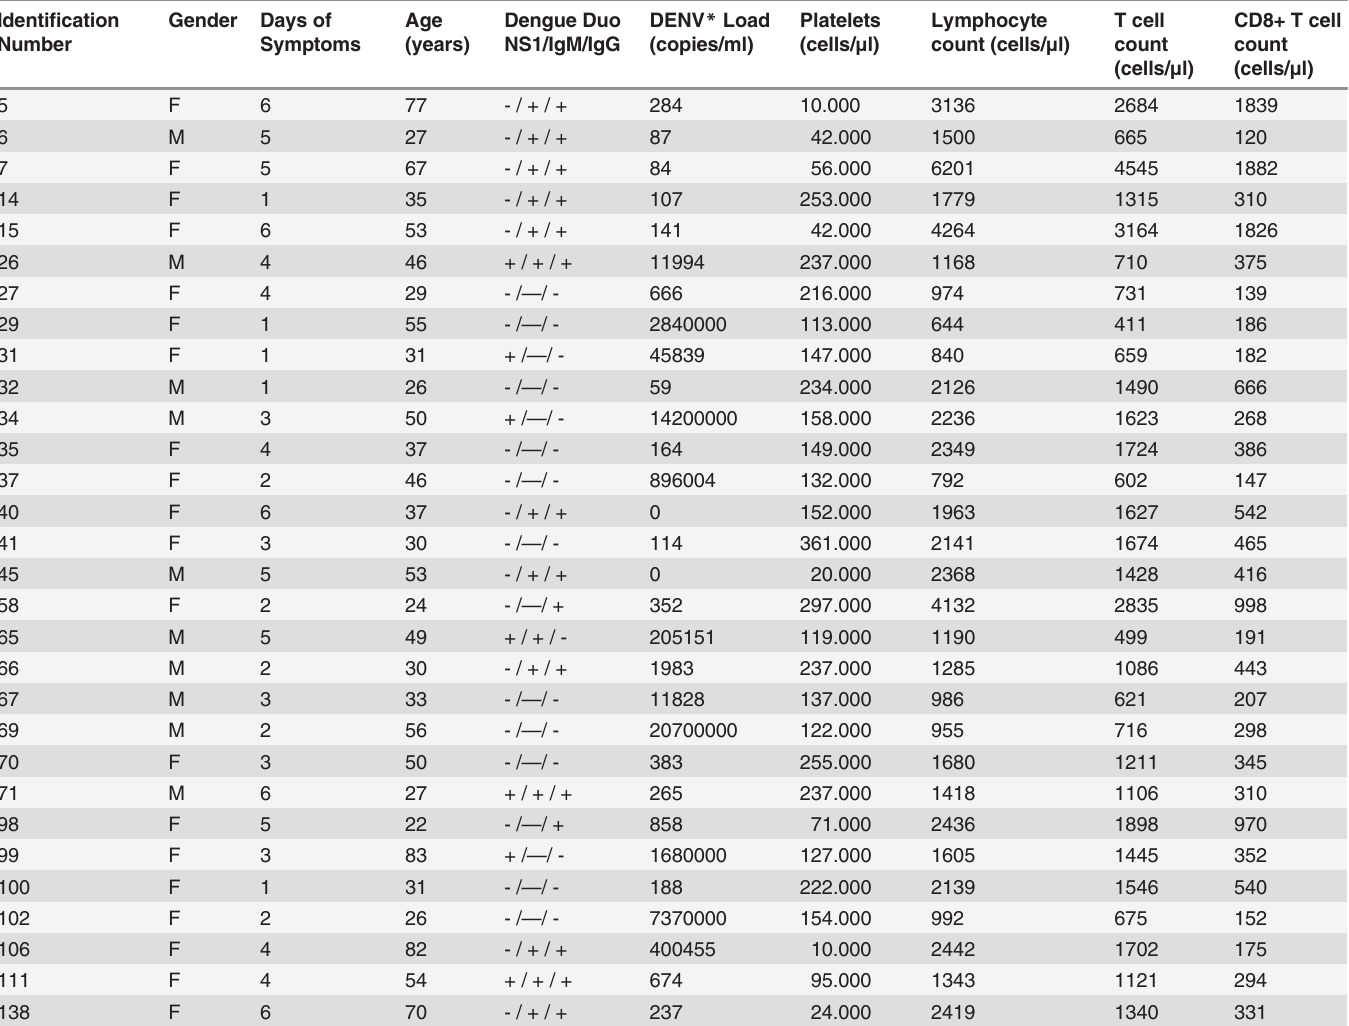
Table 2. Demographic and hematologic characteristics of study